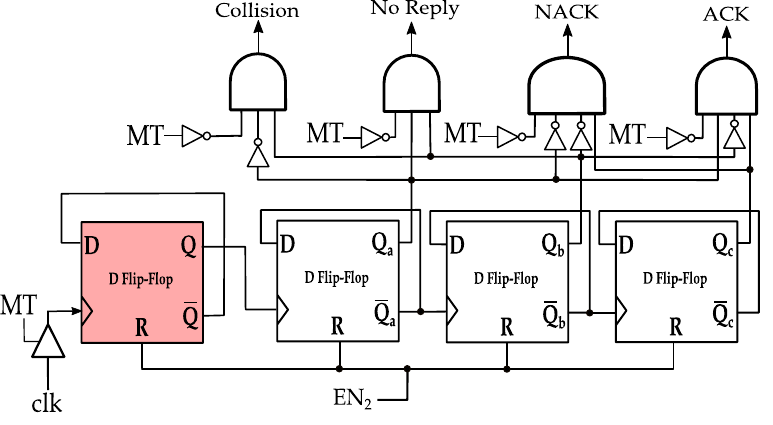
Figure 7. MCI process in anti-collision protocols with PIE encoding.